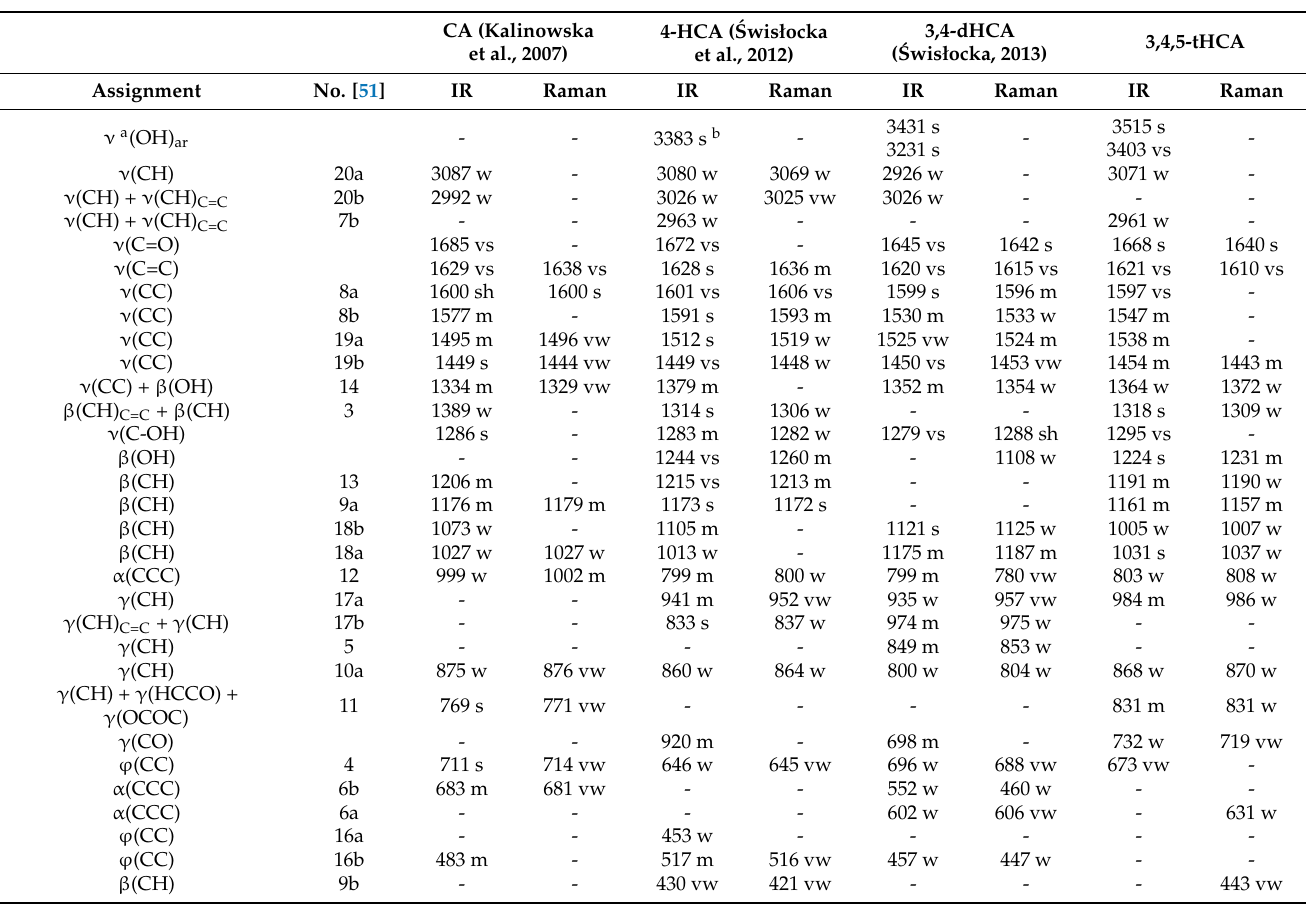
Table 1. The wavenumbers (cm − 1 ) and assignments of bands occurring in FT-IR and FT-Raman spectra of CA; 4-HCA; 3,4-dHCA; and